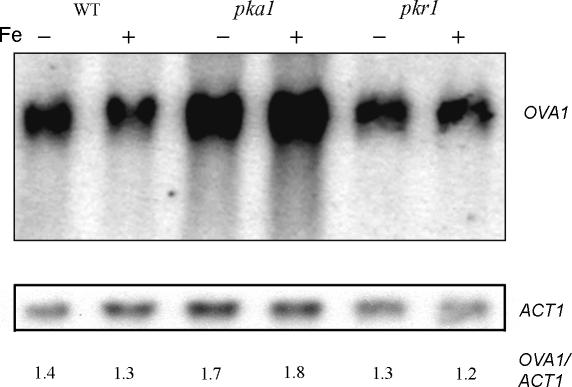
Northern Analysis of OVA1 Expression in WT and Mutant Strains in Media with Two Different Levels of IronCells were grown in LIM (designated −) and LIM + Fe (designated +). The Northern blot was prepared from total RNA and hybridized with a DNA fragment from the OVA1 gene. The same filter was hybridized with a DNA fragment from the actin gene (ACT1) as a loading control. Note that the hybridization pattern is consistent with the SAGE data, and also indicates that iron does not significantly influence OVA1 transcript levels in any of the strains. The numbers at the bottom indicate the ratio of the hybridization signals for the OVA1 and ACT1 genes, as determined from the scanned images. The expression of OVA1 was also confirmed by a quantitative real-time PCR analysis (Figure S2).